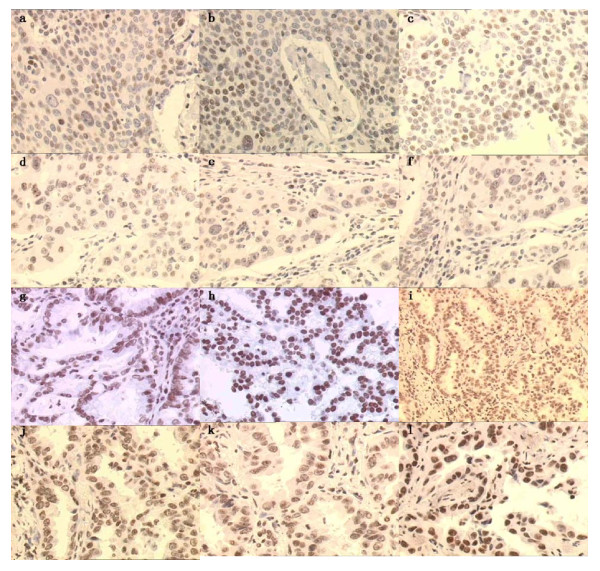
Immunohistochemical staining of ERCC1 proteins in NLCLC tissues. Expression of ERCC1 protein was detected in the nuclei of cancer cells. a-f: squamous carcinoma; g-l: adenocarcinoma.